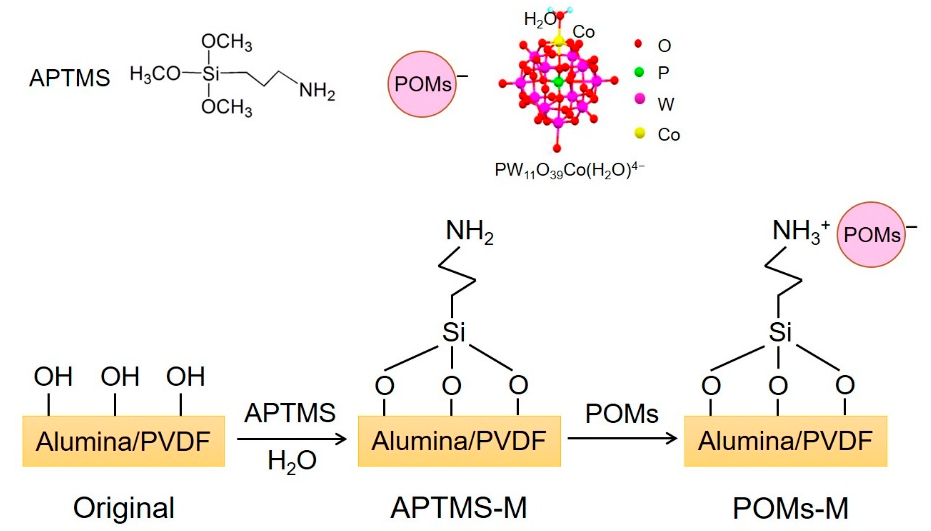
Figure 8. Proposed reaction route for POMs-modified membranes (POMs-M).